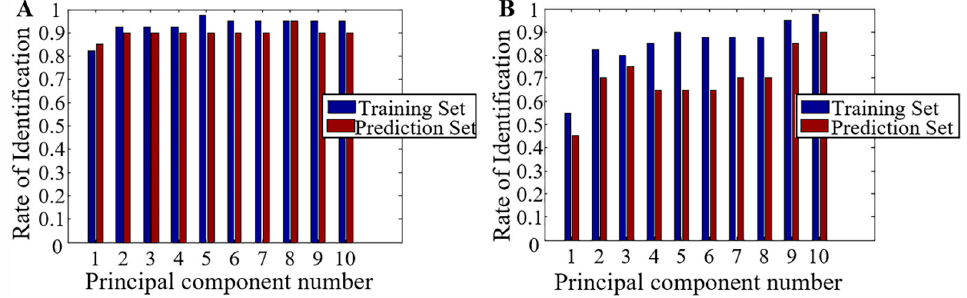
Figure 5. Classification results by linear discriminant analysis (LDA) in different reaction chambers. ( A ). The new reaction chamber; ( B ) the free gas volatile reaction chamber.